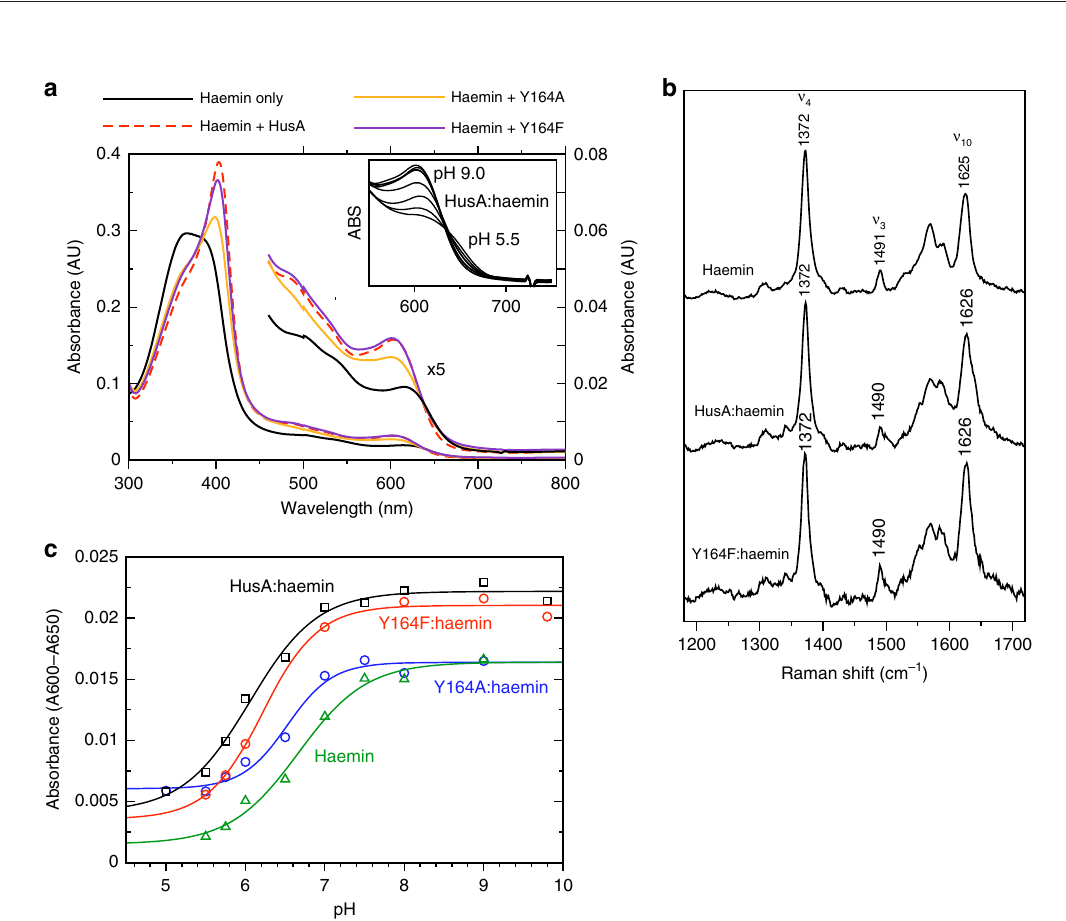
Fig. 2 The structure of HusA and analysis of the porphyrin/haem binding site. a Ensembles (stick backbone representation) of HusA conformer set 1 (cyan) and alternative conformer set 2 (orange; 20 lowest energy structures in each) calculated in CYANA 3, and the energy minimized average structures (ribbons) showing different orientations of the W130 side chain and adjacent α 7 α 8 loop. b Superimposed DAMMIN models from SAXS data (semi-transparent pink, cyan and yellow spheres for HusA in reduced and standard buffers and HusA:haem, respectively) overlaid with the representative NMR structure (ribbon). c Mapping the porphyrin-binding site in HusA. NMR signal intensity changes (black) and 1 H N chemical shift perturbations (CSPs; red/green), measured from 15 N-HSQC spectra (Supplementary Figures 9 – 11 and Supplementary Table 5) upon addition of haemin or ZnPPIX or DPIX. Signal intensity changes are plotted for a HusA:porphyrin molar ratio of 2:1. CSPs were measured for detectable signals with porphyrin in molar excess. d Residues experiencing a reduction in NMR signal (orange) or up- fi eld CSP (red) or down- fi eld CSP (green) above thresholds shown in c (dashed lines) are shown as spheres. Side chains that were mutated are annotated. e UV-visible spectra of 10- μ M haemin, alone or in the presence of 10- μ M HusA or HusA mutants, recorded at pH 8.0. f Scaled and corrected fl uorescence at 335 nm recorded from titrations of HusA or HusA mutants (1 μ M concentration) with increasing concentrations of haemin. Measured fl uorescence data points (symbols) were fi tted to a 1:1 binding model (Supplementary Figure 14). g Representative pooled results for docking a porphyrin ligand (haemin, PPIX or DPIX) to the energy minimized average structure of HusA NMR conformer set 1 (cyan) or HusA NMR conformer set 2 (orange) showing the range of poses adopted (yellow, purple sticks). Only the position of the porphyrin ring, which was similar for haemin, PPIX or DPIX, is shown. Cluster analysis of all docking results is shown as Supplementary Figure 20a